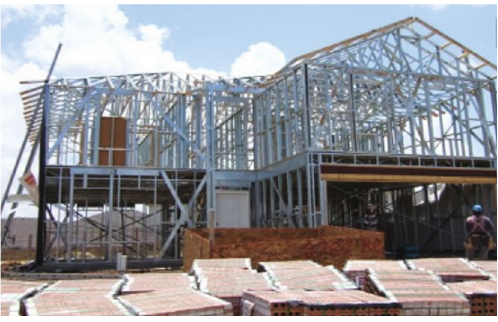
Figure 1: Light steel-wood-plastic structure